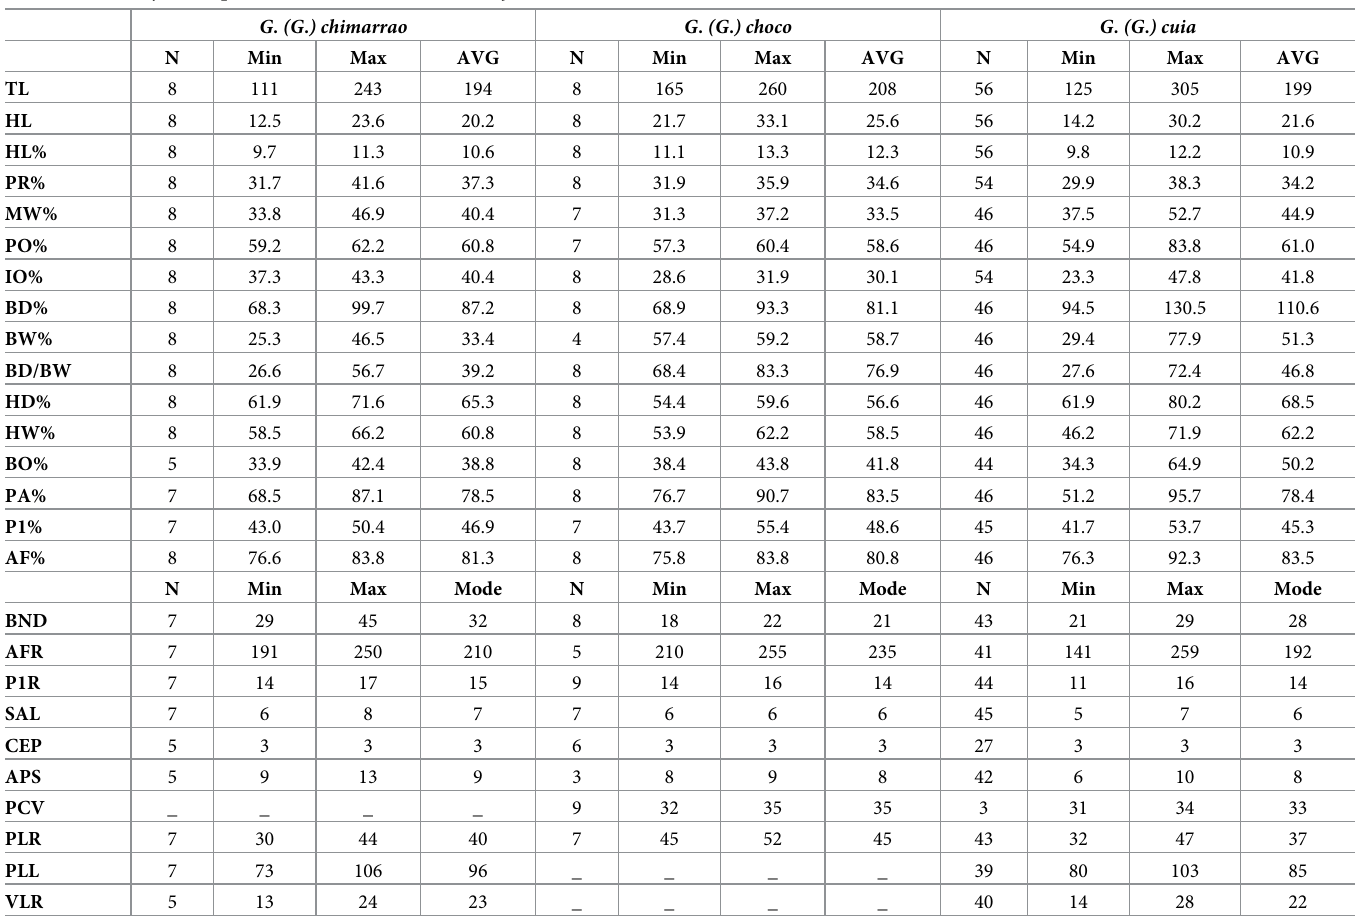
Table 8. Summary of morphometric and meristic data for Gymnotus (G . ) chimarrao , G . (G . ) choco and G . (G . ) cuia . G . (G . )